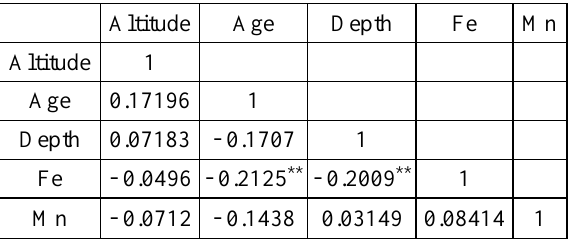
Table 13. Pearson’s correlation coefficient